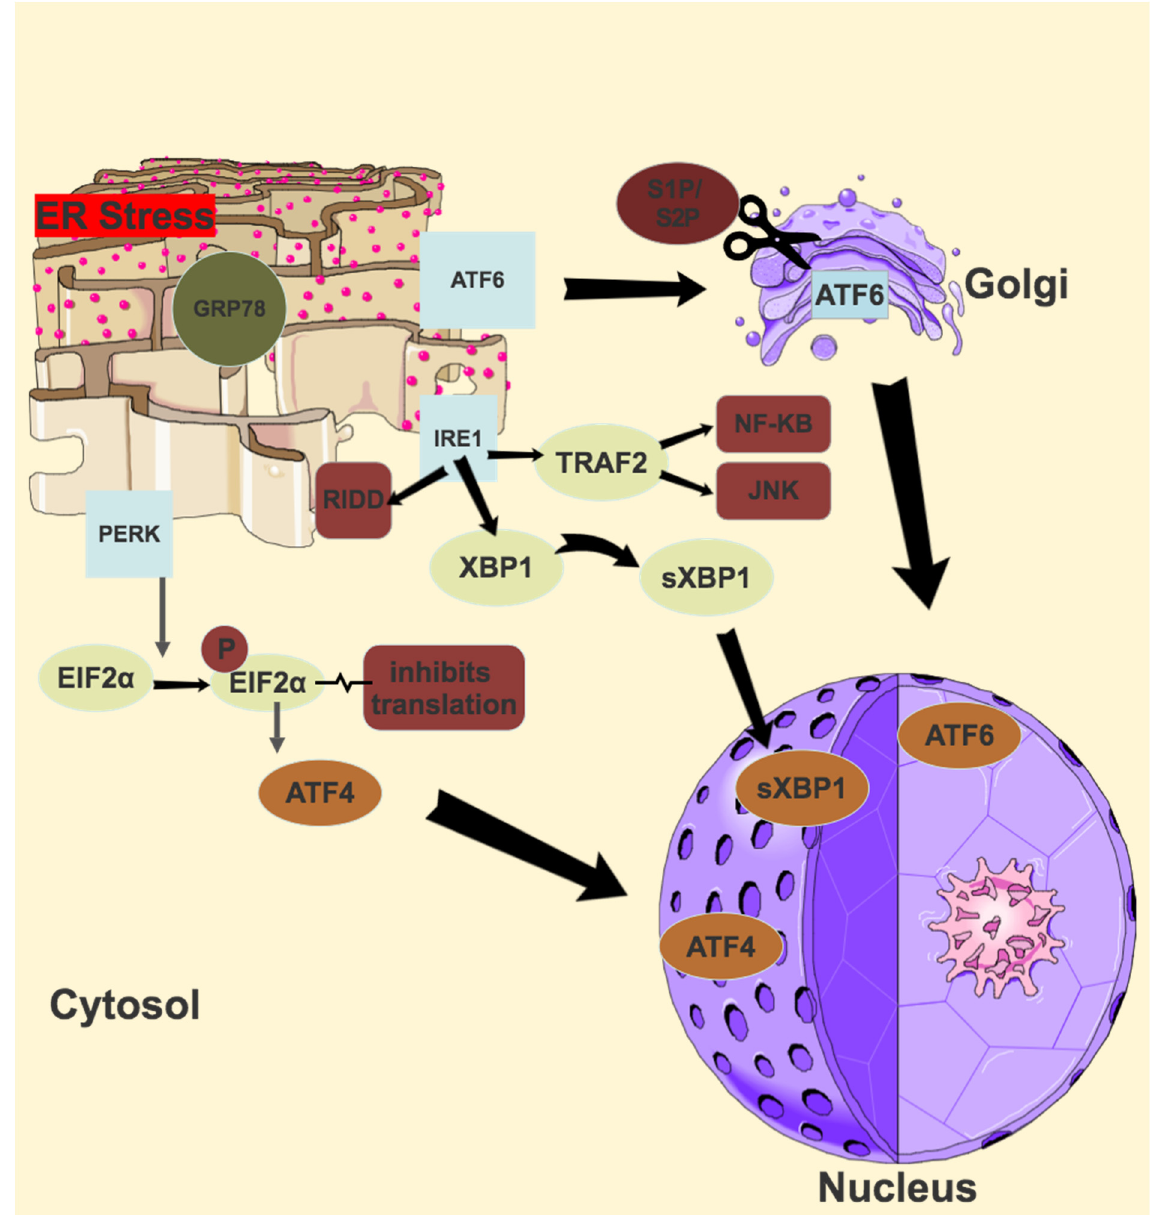
Figure 3. Unfolded protein response (UPR) Pathways.